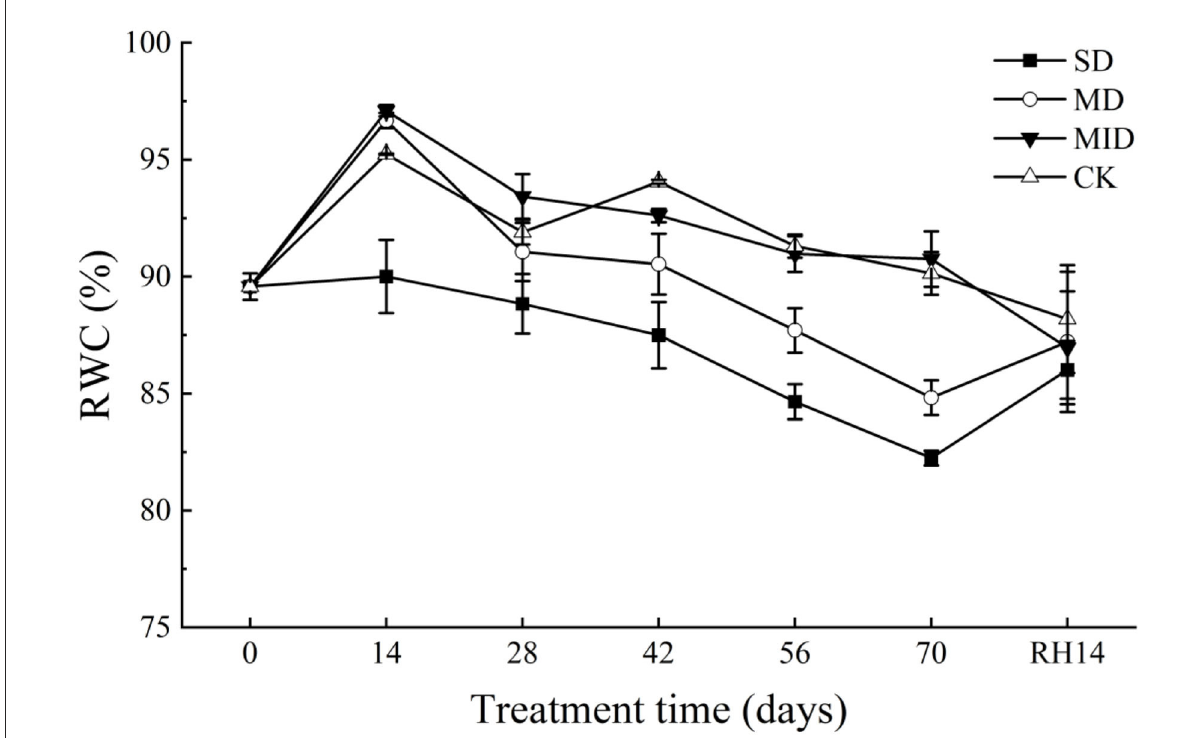
FIGURE6 RWC during the drought and rehydration for A. selengensis . Fourteenth day of rehydration (RH, 14 days), the severe drought group (SD), the moderate drought group (MD), the mild drought group (MID), and the control group